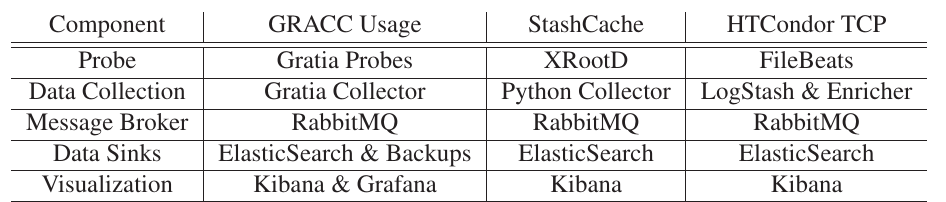
Table 1. Components of the example GRACC data